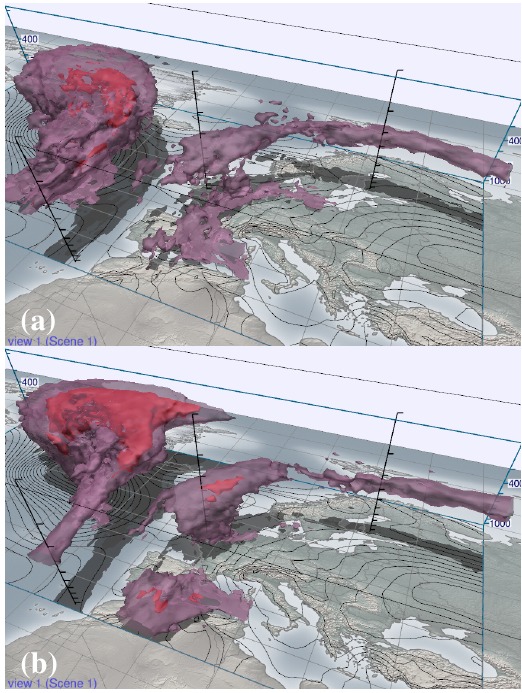
Figure 19. Convergence of p( WCB ) with decreasing forecast lead time. Forecasts from (a) 12:00UTC, 15 October 2012 and (b) 12:00UTC, 16 October 2012, valid at 18:00UTC, 19 October 2012. Filter criterion is 500hPa in 48h. Isosurfaces show 30% (red opaque isosurface) and 10% (purple transparent isosurface). Black surface contours show ensemble mean sea level pressure. The fore- cast from 00:00UTC, 17 October 2012 is shown in Fig.